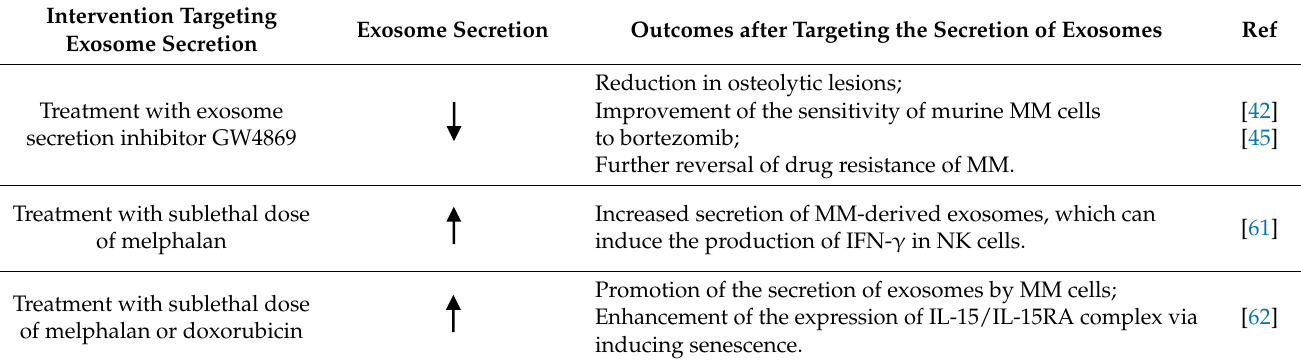
Table 2. Therapies targeting the secretion of exosomes.